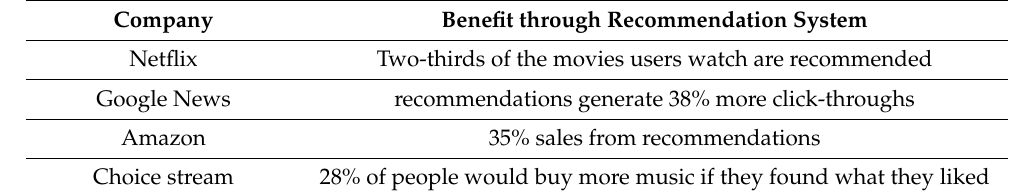
Table 1. Companies’ benefits through recommendation